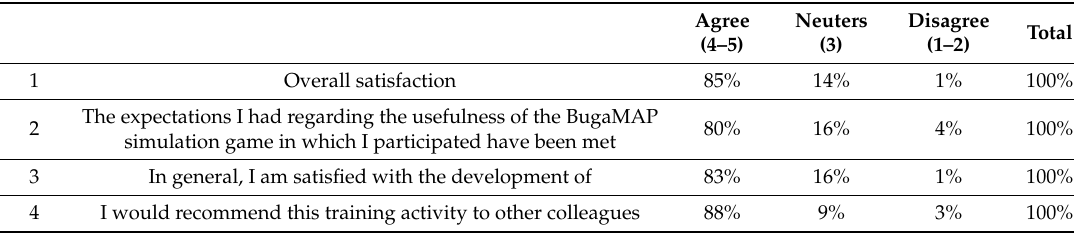
Table 5. Self-perceived satisfaction of the BugaMAP